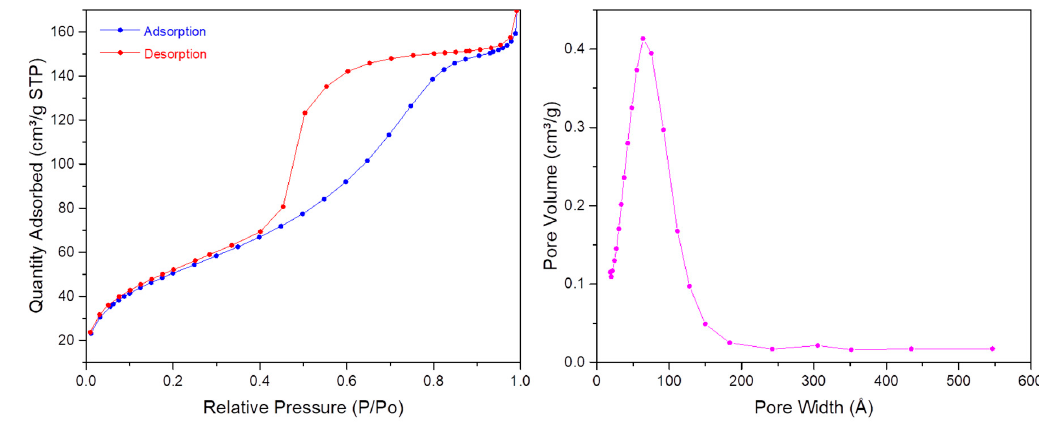
Figure 7. TEM of P3 Periodic Mesoporous Organosilica Nanoparticles ( PMONPs) at different magnifications.